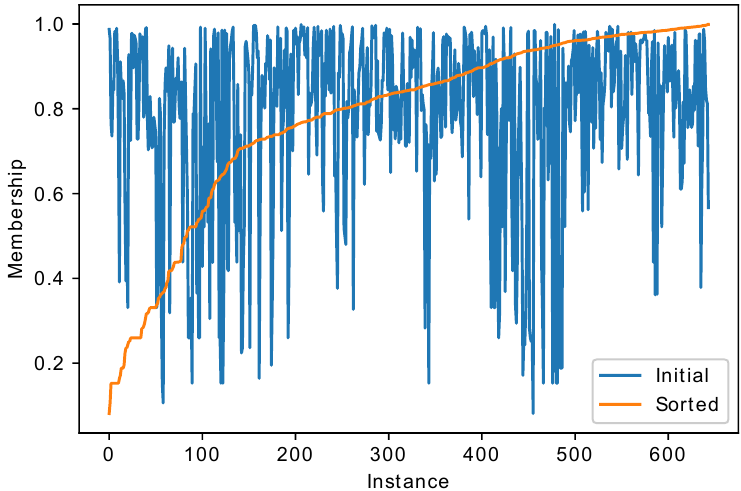
Figure 5. Fuzzy membership values returned by HEFCA algorithm, satimage dataset, test set.